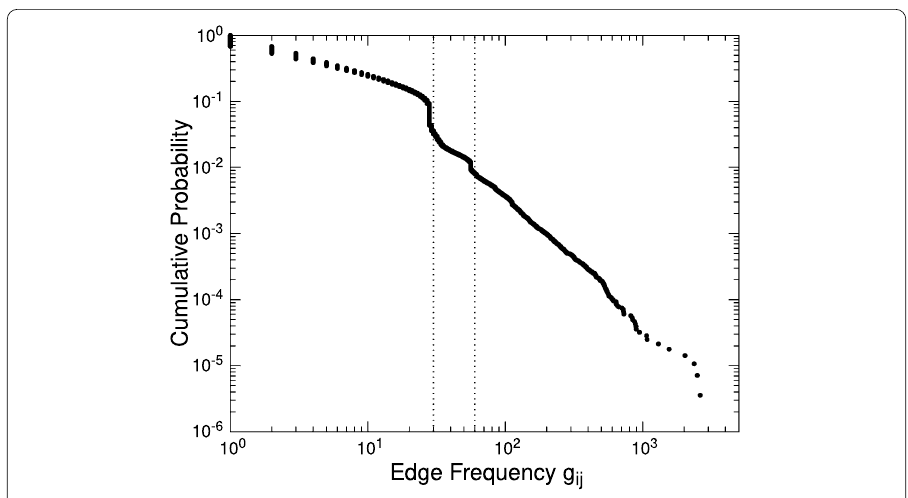
Figure 5 Distribution for the frequencies of transfers. Complementary cumulative distributions for the frequency defined by g ij between each pair of accounts i and j (see Fig. 1). We can observe that there are frequency steps around 30 and 60 (vertical dotted lines), which are presumed as periodic transfers performed once or twice in each month (recall that the entire period includes 29 months)